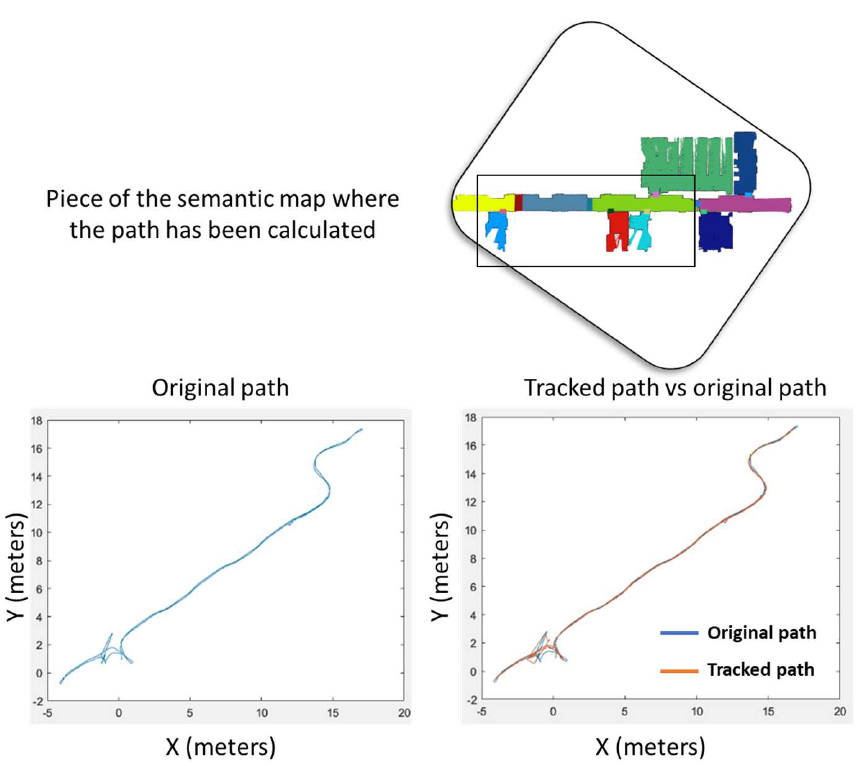
Figure 7. Original and tracked path when the robot is sent to different goal positions during an experiment in the laboratory.